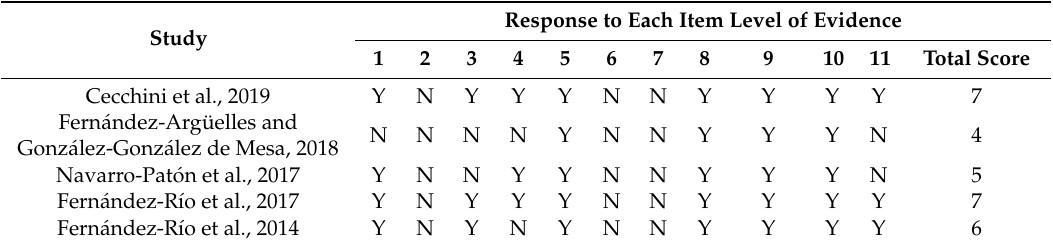
Table 1. Risk of bias according to the PEDro